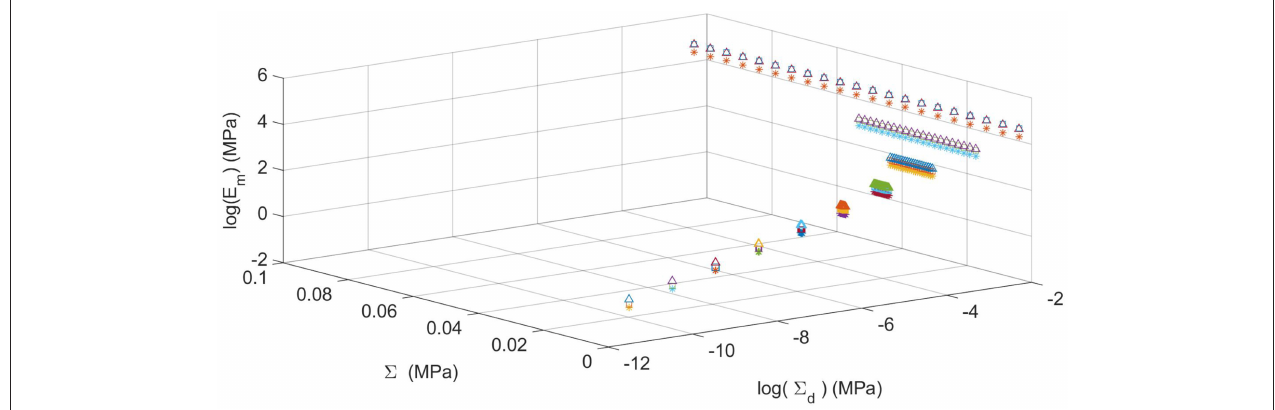
FIGURE 6 | Young modulus vs. the actual macrostress 6 at different values of the design macrostress 6 d . The symbols △ , (cid:3) ,*, refer to triangular, quadrangular, and hexagonal cells, respectively.